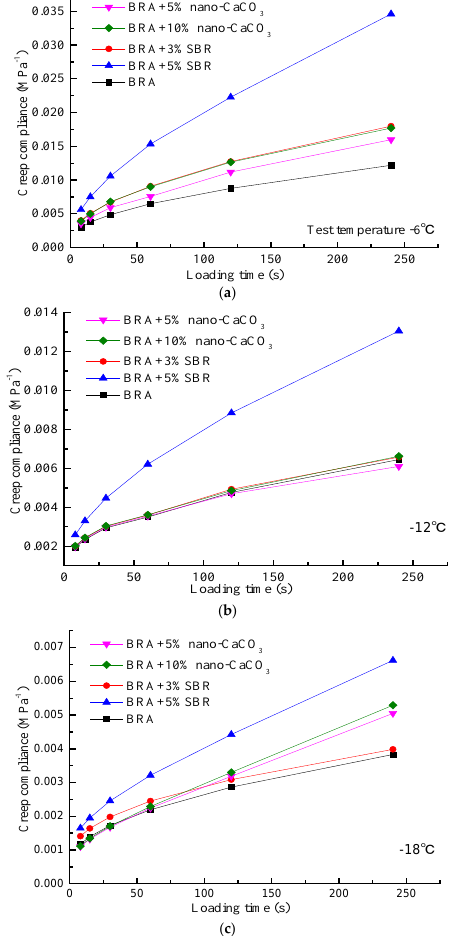
Figure 9. Creep compliance curve of different compound-modified asphalts : ( a ) the curves of creep compliance of BRA compound- modified asphalt in −6 °C; ( b ) the curves of creep compliance of BRA Figure 9. Creepcompliancecurveofdifferentcompound-modifiedasphalts: ( a )thecurvesofcreepcompliance compound- modified asphalt in − 12 °C; ( c ) the curves of creep compliance of BRA compound- of BRA compound-modified asphalt in − 6 ◦ C; ( b ) the curves of creep compliance of BRA compound-modified modified asphalt in − 18°C. asphalt in − 12 ◦ C; ( c ) the curves of creep compliance of BRA compound-modified asphalt in − 18 ◦